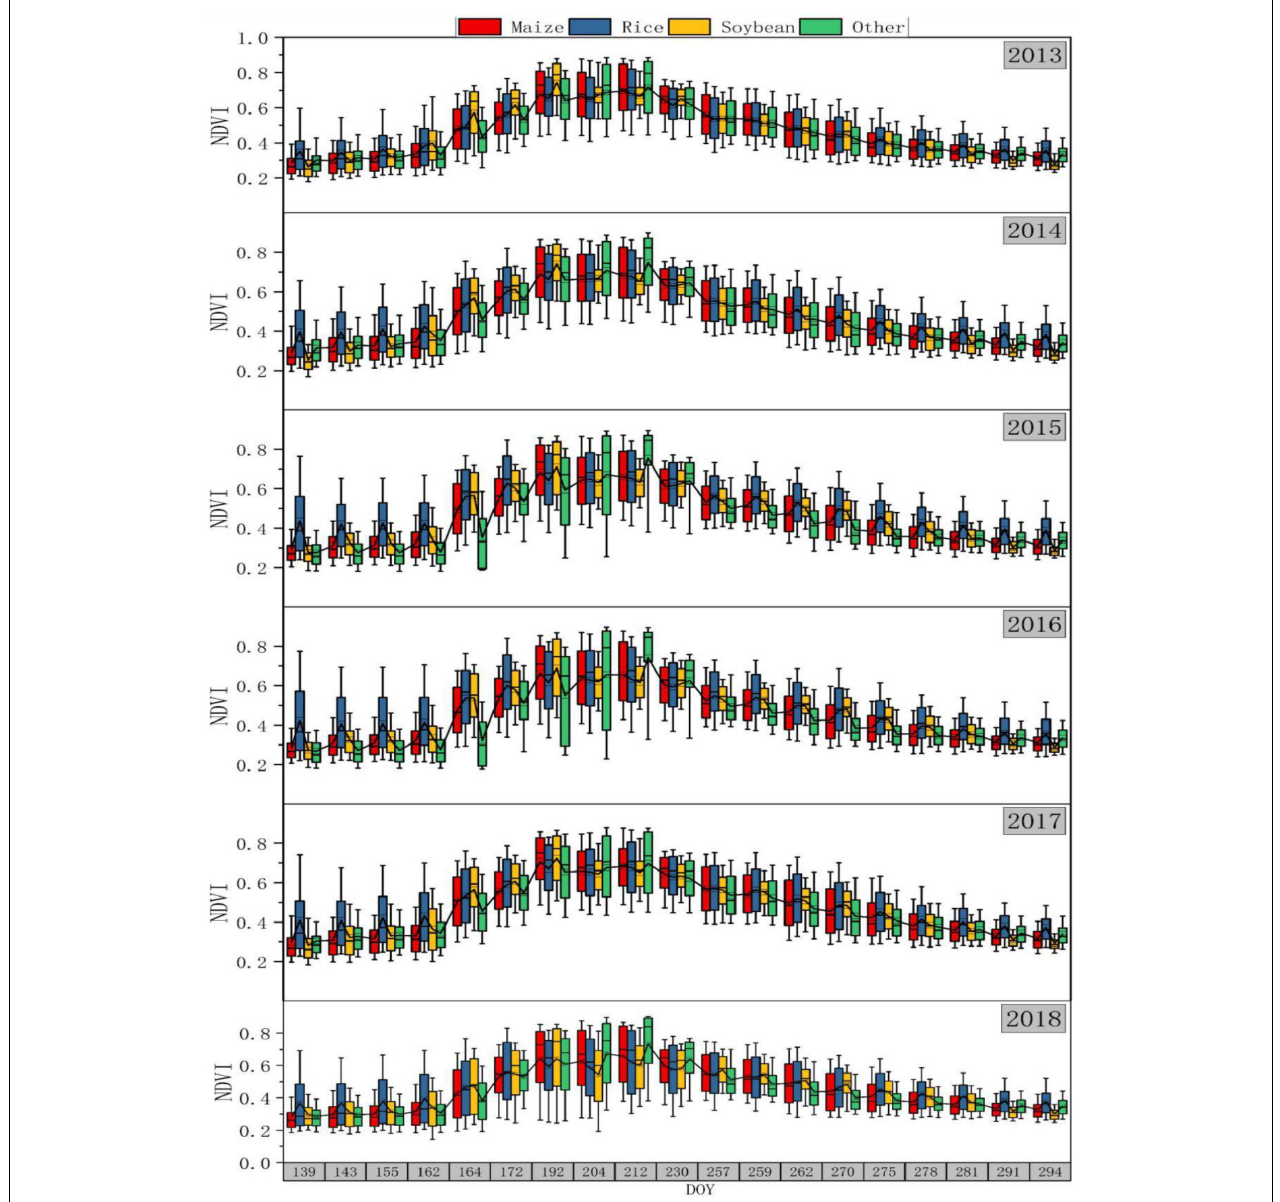
FIGURE 9 | Time series box diagram of NDVI in newly generated